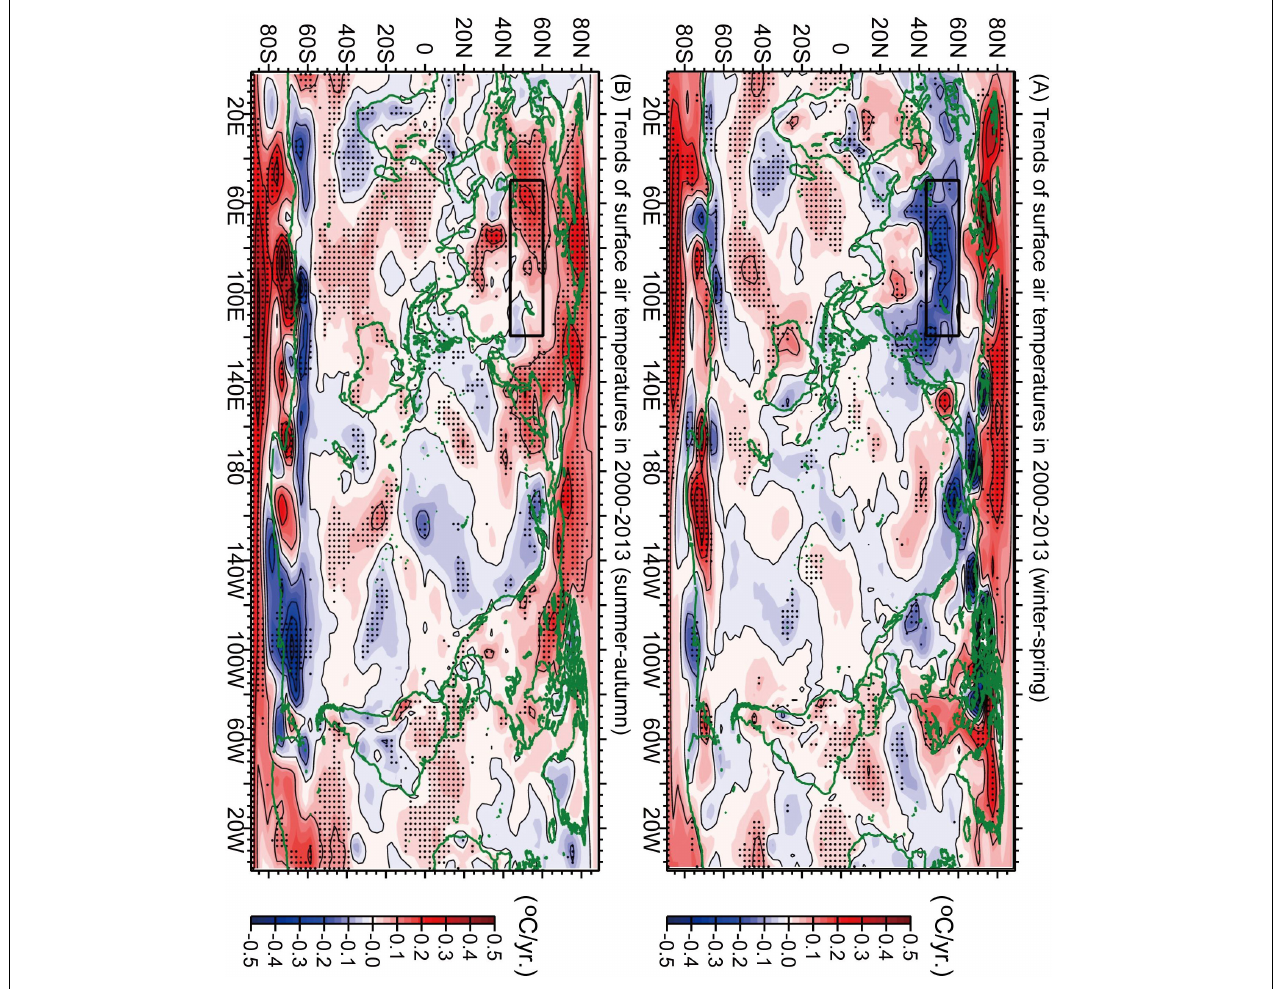
FIGURE 3 | Trends of surface air temperatures in 2000–2013 for (A) winter–spring and (B) summer–autumn. Significant trends ( P < 0.10) are denoted by dots. The area defined as “Central Eurasia” is outlined by the black rectangle.